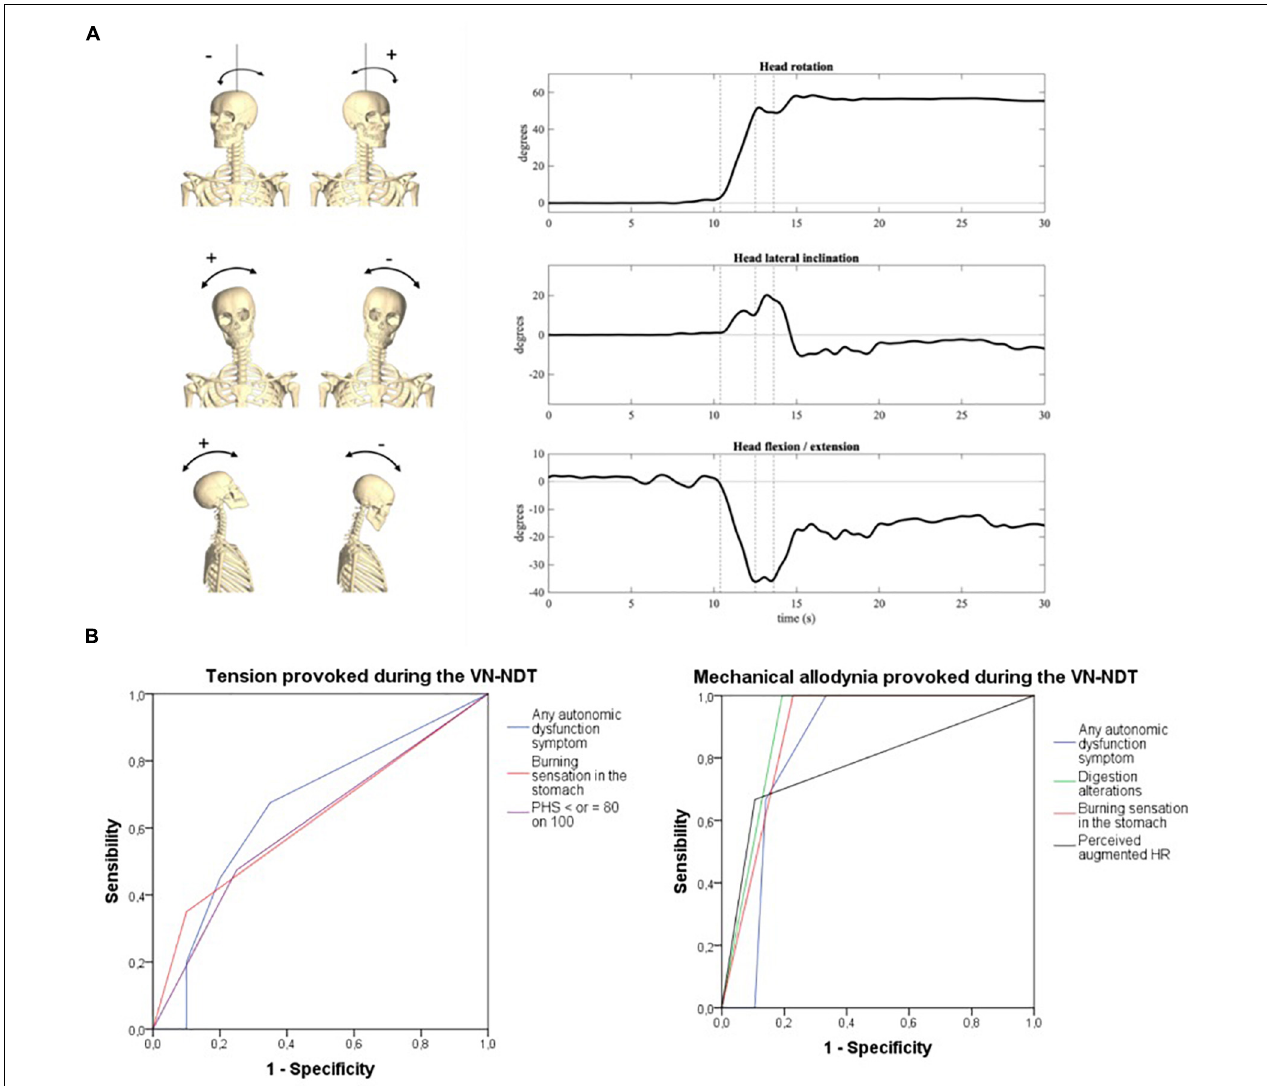
FIGURE 4 | (A) Head orientation at the end of the neurodynamic test (R: head inclined on the right of the subject; L: head inclined on the left of the subject). (i) Inclination, (ii) rotation, and (iii) flexion/extension. The three dotted vertical lines in the graphs represent the three movements of the VN-NDT combined from the left to the right: upper cervical flexion, contralateral later flexion, and ipsilateral rotation, respectively. (B) ROC curves of symptoms related to vagal dysfunctions or autonomic peripheral neuropathies detected by the onset of tension (left) and pain (right) in the neck during the vagus nerve neurodynamic test. PHS, perceived health status; HR, heart